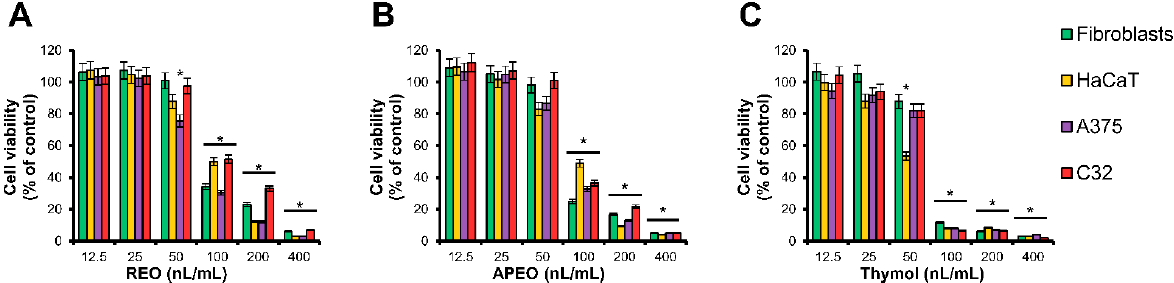
Figure 2. Cell viabilities of human skin fibroblasts, HaCaT keratinocytes and human melanoma cell lines A375 and C32, treated with different concentrations of C. cernuum essential oils and thymol for 48 h: ( A ) Essential oil from roots (REO), ( B ) essential oil from aerial parts (APEO) and ( C ) thymol. Data are presented as mean ± standard error of the mean (SEM) from three independent experiments. * p < 0.05 compared to control group. Table 3. The half-maximum inhibitory concentration (IC 50 ) values (nL/mL) calculated for the